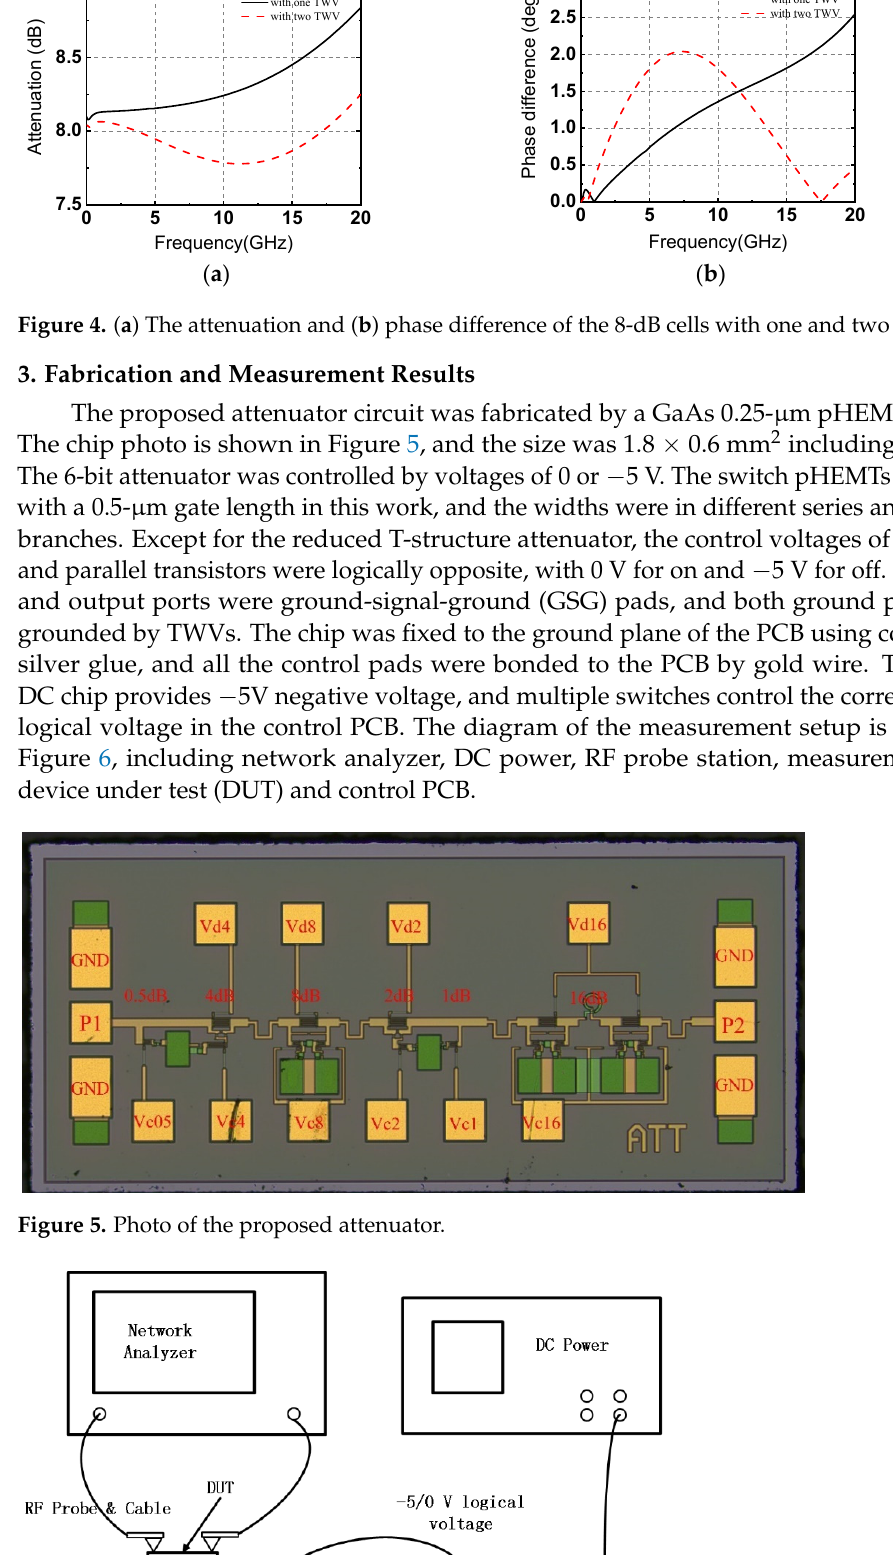
Figure 9. The root mean square (RMS) errors of the attenuation and insertion phase shift